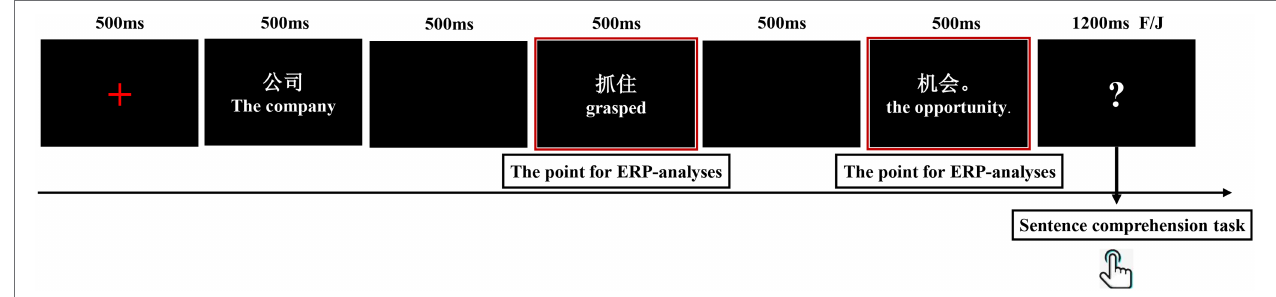
FIGURE 1 | Trial structure of the